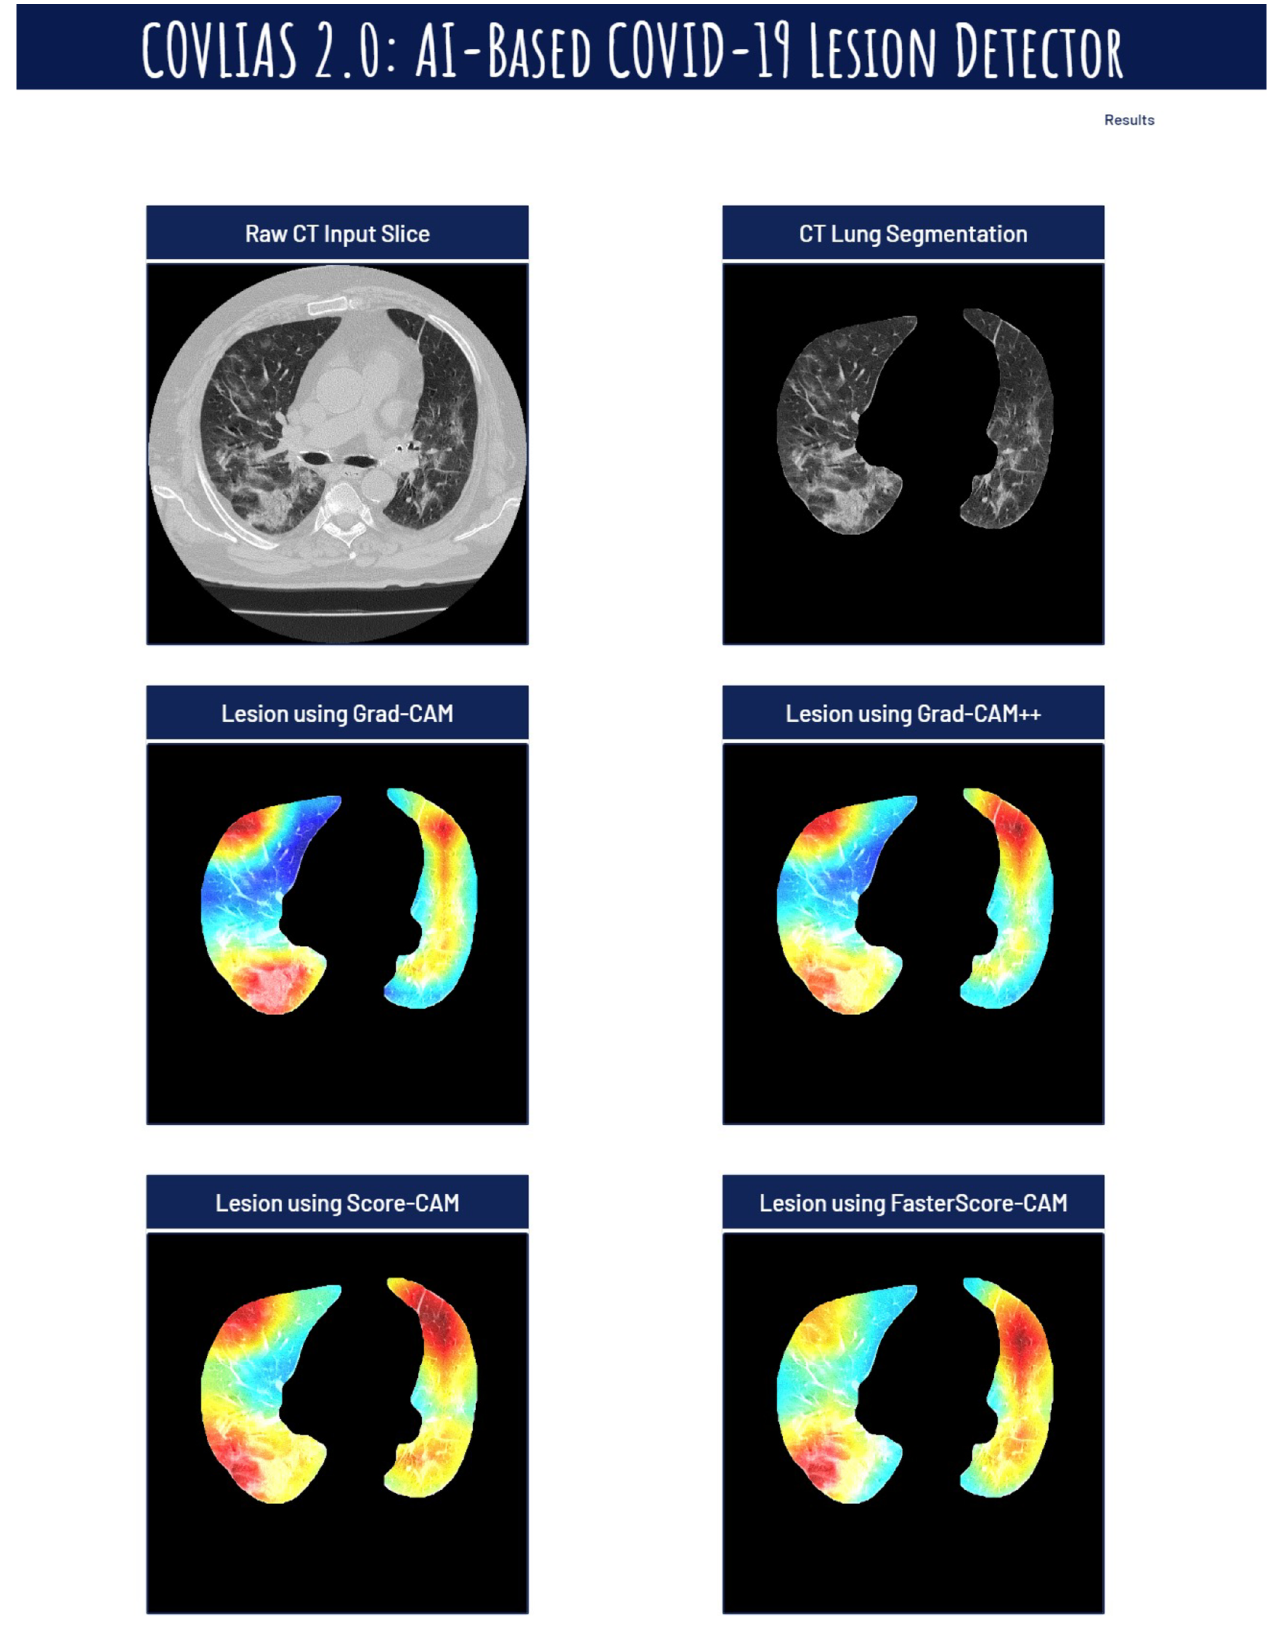
Figure 21. COVLIAS 2.0 cloud-based display of the lesion images using four CAM models.